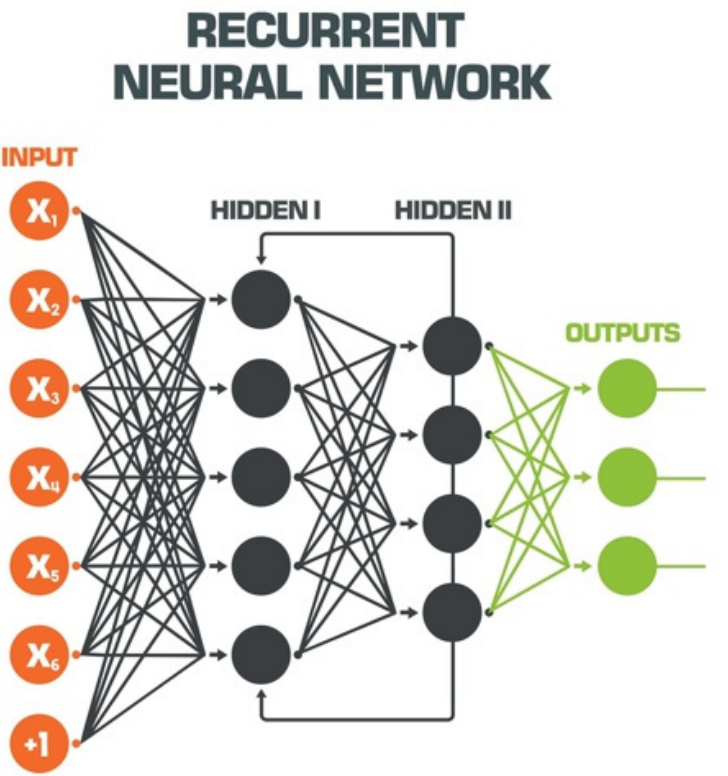
Figure 5. Recurrent Neural Network (ShadeDesign/Shutterstock.com, accessed on 27 April 2022). CNN models may use WSIs ascribed individual diagnostic target-labels per associated pattern, e.g., Gleason grade, or up to millions of unlabeled WSI image-patches for